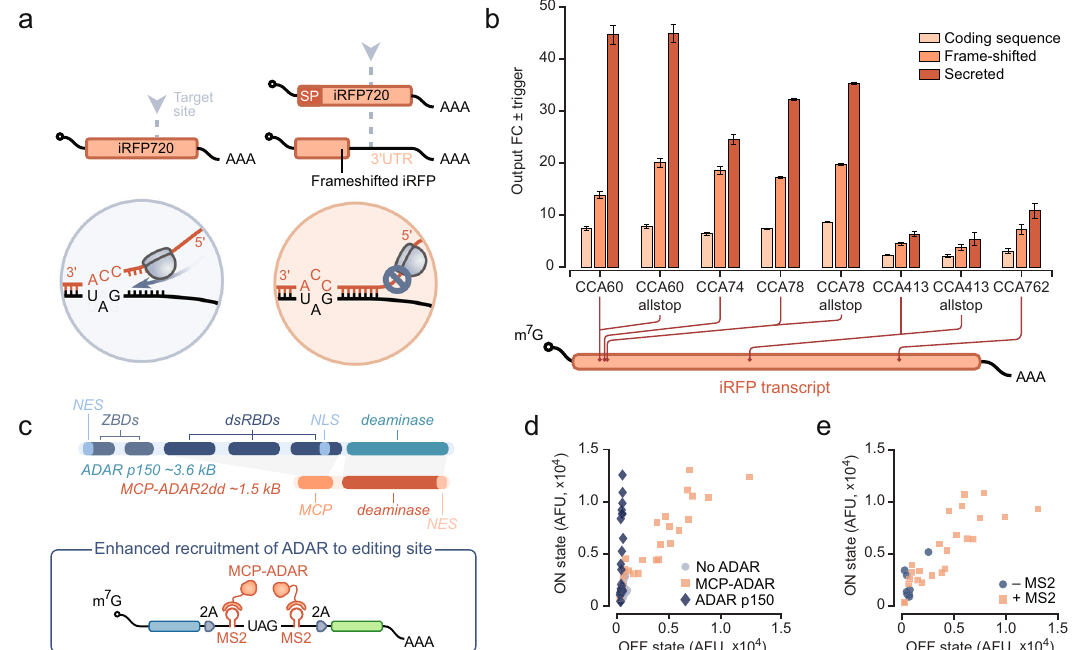
Fig.2|OptimizationofDARTVADARinputsandoutputs.a Theperformanceof sensors (black) targeting a sequence in the coding sequence of a transcript is hypothesizedtobediminishedduetodehybridizationbyribosomestranslatingthe triggersequence(orange).Giventhis,theperformanceofsensorsdesignedagainst secreted proteins or 3 ’ UTR sequences is expected to be enhanced as stalled and dissociated ribosomes are less likely to disrupt sensor-trigger hybridization. SP: signal peptide; UTR: untranslated region. b ADAR-based sensors yield higher dynamic range when designed to target the 3 ’ UTRs of transcripts, or coding sequences of secreted proteins. “ allstop ” indicates that all the sites in the sensor aligning with CCA sites in the target were made into editable UAG codons (as opposed to only the central codon). The value of each bar corresponds to the output fold-change (FC),which is the ratioof the geometric meanof mNeonGreen